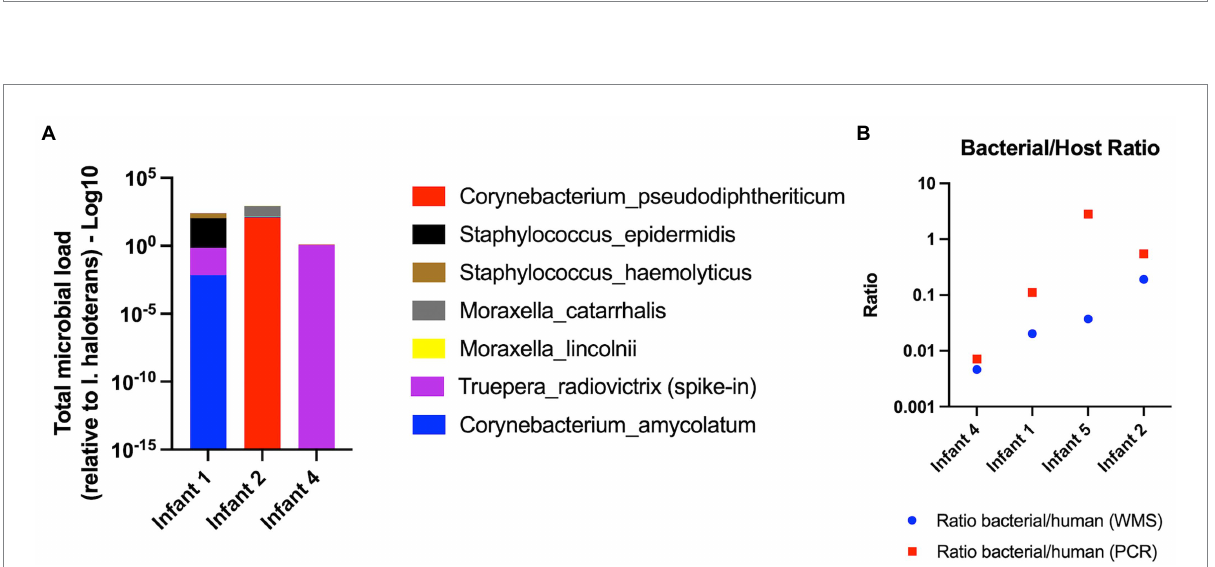
FIGURE 8 Individual patient samples. (A) . Total microbial load relative to the abundance of I. haloterans (log scale). (B) Bacterial/Host DNA ratio for individual patient samples evaluated with real time qPCR (red) and WGS